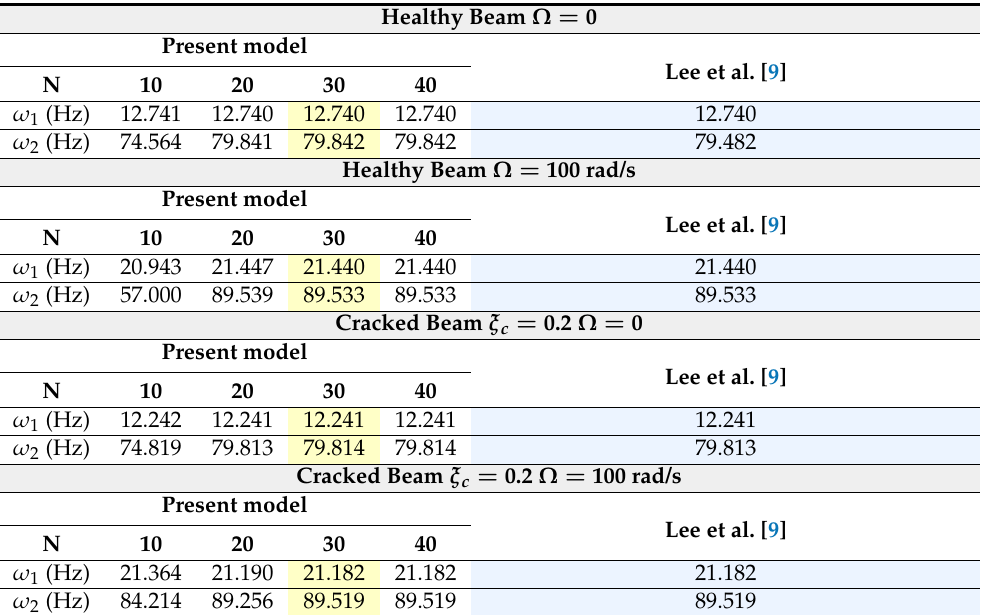
Table 1. Comparison between the present model results and results from Lee et al. [9]. Reprinted/adapted with permission from [9]. 2016, Springer